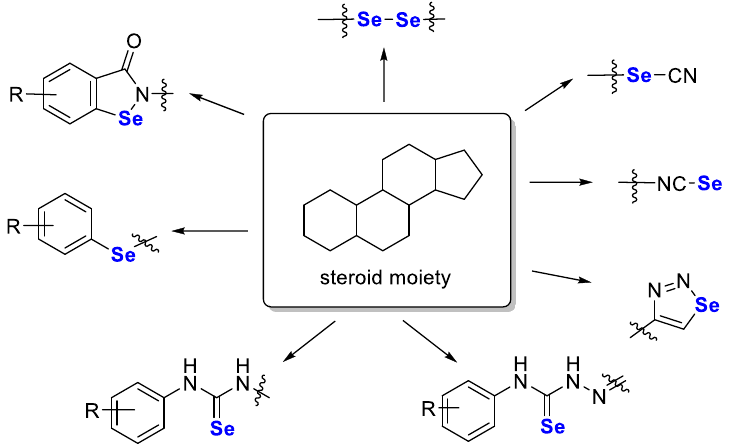
Figure 6. General structure of selenium-based hybrids of steroid derivatives described in the review of Jastrzębska et al. [98].